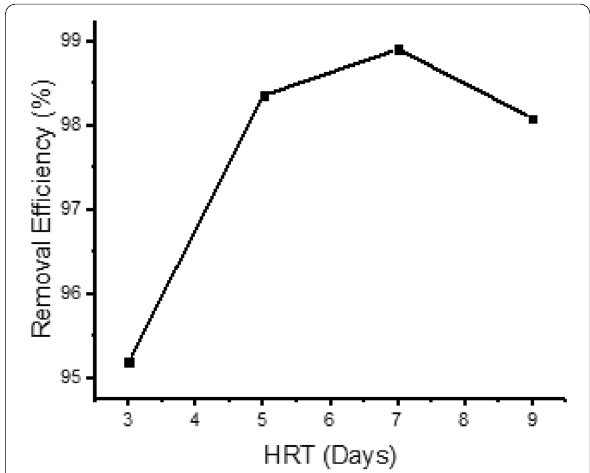
Fig. 6 Chromium removal efficiency of HSSFCW with pumice